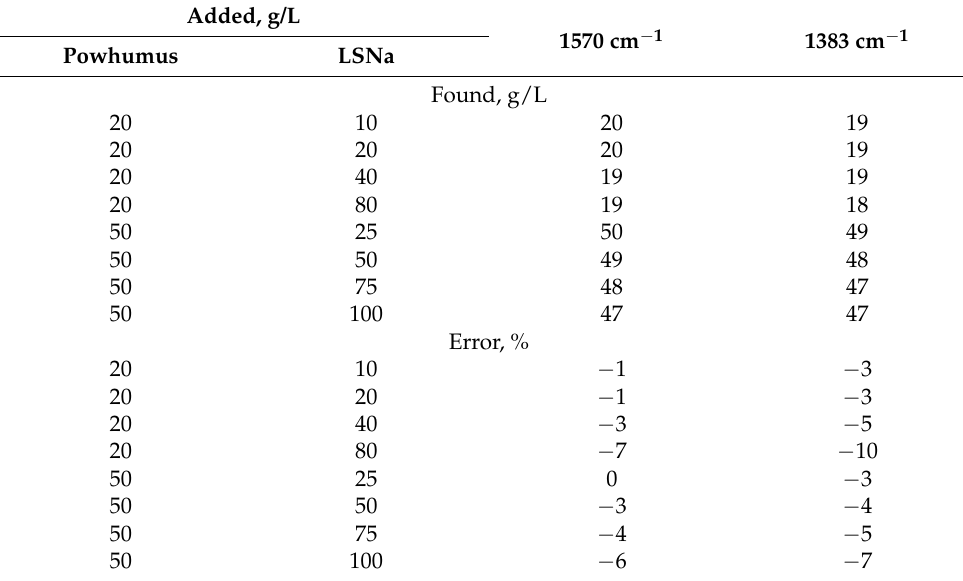
Table 7. The error of humate quantification in the mixtures with lignosulfonate by the characteristic bands of both humate and